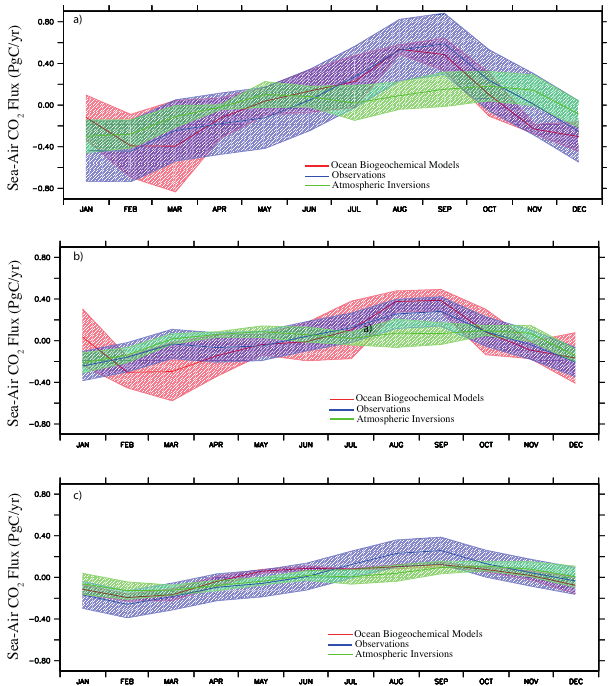
Fig. 6. Seasonal cycle anomaly of the Southern Ocean sea–air CO 2 flux (PgCyr − 1 ) from observations, ocean biogeochemical and at- Figure 6 Seasonal cycle anomaly of the Southern Ocean sea-air CO 2 flux (PgC/yr) 1226$ mospheric inversions for the Southern Ocean (44–75 ◦ S; upper), the from observations, ocean biogeochemical, and atmospheric inversions for the 1227$ region 44–58 ◦ S (middle) and the region south of 58 ◦ S (lower). The Southern Ocean (44 ° S-75 ° S; upper), the region 44 ° S-58 ° S (middle) and the region 1228$ shaded area represents the sea-air CO 2 flux uncertainty associated south of 58 ° S (lower). The shaded area represents the sea-flux CO 2 flux uncertainty 1229$ with each approach. Negative values reflect flux into the ocean. associated with each approach. Negative values reflect flux into the ocean. 1230$